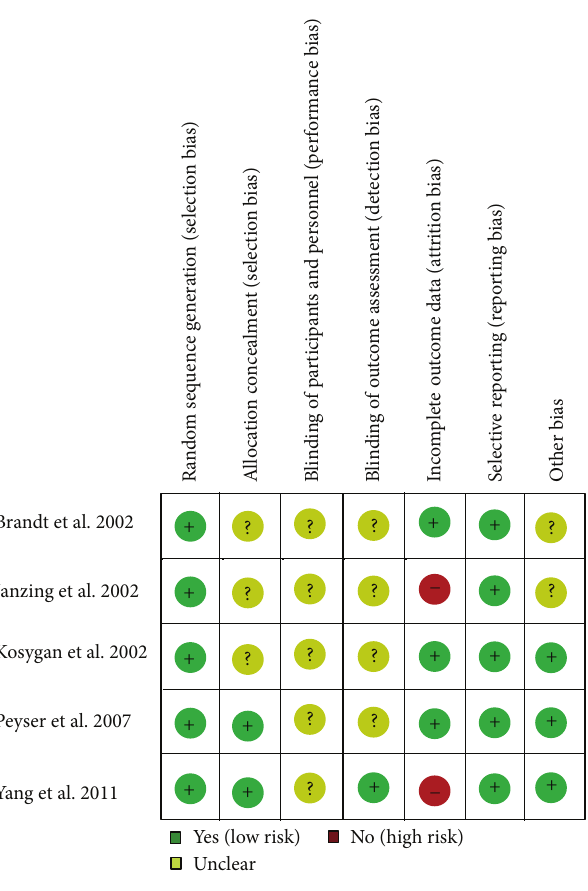
Figure 2: Methodological quality of included studies. This risk of bias tool incorporates assessment of randomization (sequence generation and allocation concealment), blinding (participants, personnel, and outcome assessors), completeness of outcome data, selection of outcomes reported, and other sources of bias. The items were scored with “yes,” “no,” and